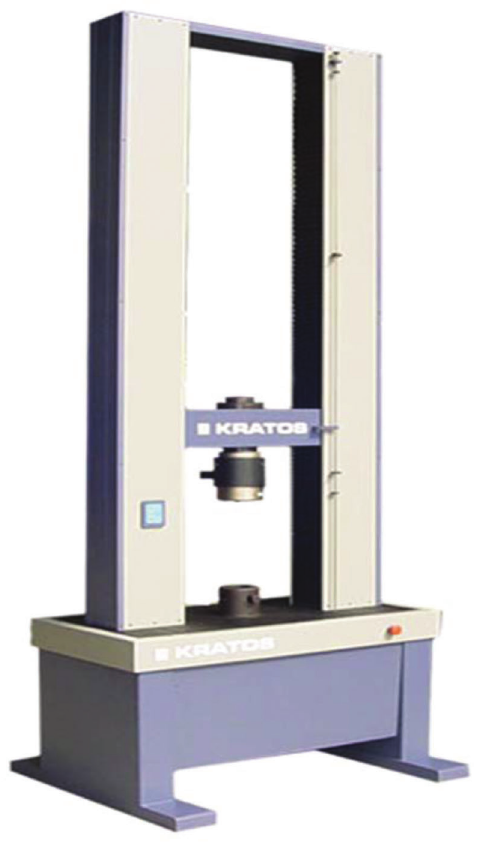
Figure 1 - ACL reconstruction technique with double bundle described by Carneiro et al. Figure 2 - The Kratos universal mechanical testing